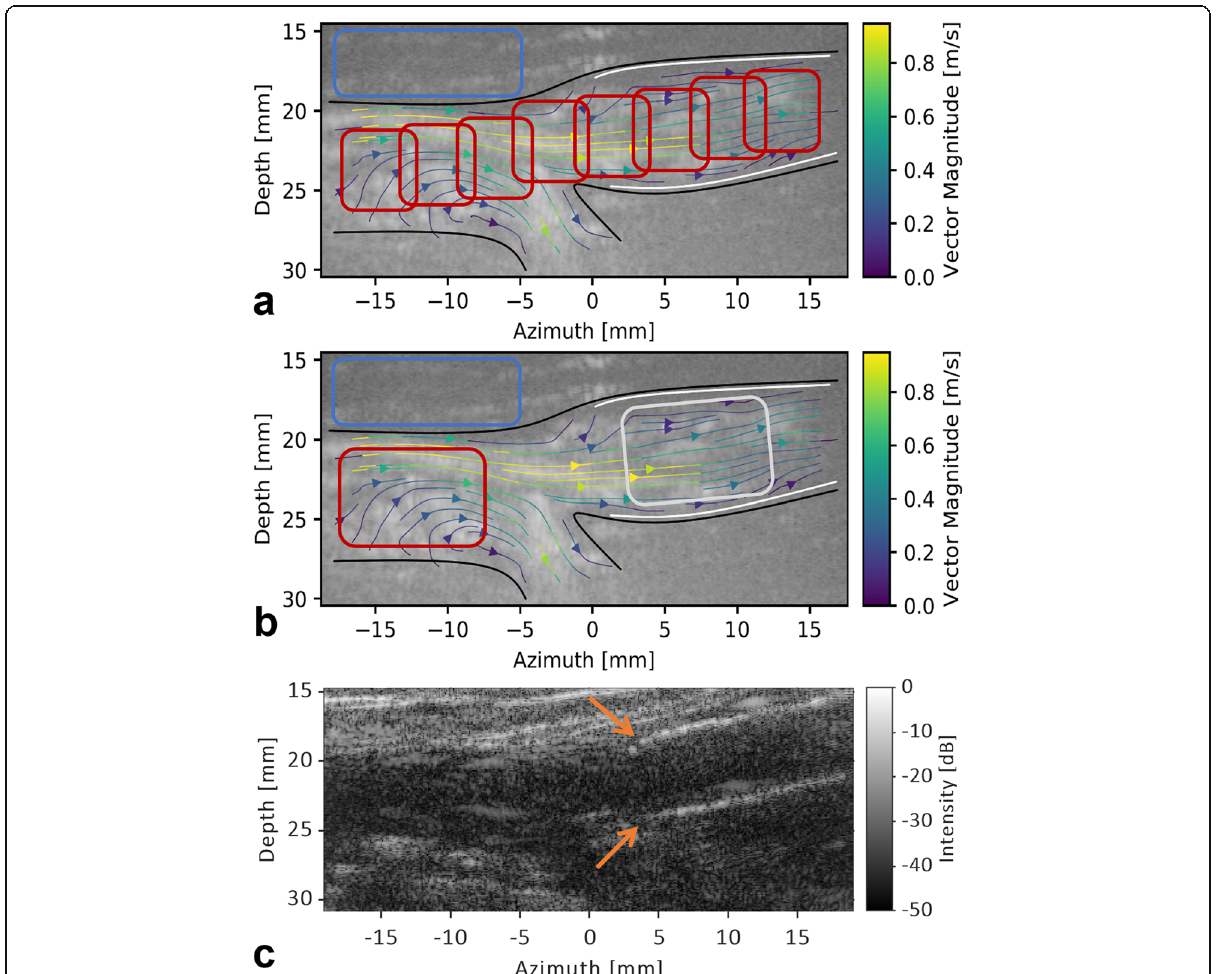
Fig. 3 Example indicating the stent location and regions of interest (ROIs) used for the quantitative analysis. a , b Filtered contrast-enhanced US image captured at the proximal edge of the stent (white lines) with the velocity streamlines superimposed. a ROIs used to analyse the entire imaged vessel. To calculate the contrast-to-tissue ratio (CTR), the red squares were used for contrast signal strength whereas the blue square was used for tissue signal strength. Black lines represent the delineation of the imaged vessel. All vectors inside this (masked) region were used to calculate the average vector correlation. b ROIs used to analyse the stent influence. CTR was calculated for both the red (contrast strength in native vessel segment) and grey square (contrast strength in stented vessel segment) compared to the blue square. The average vector correlation was computed over all vectors inside the red and grey square for the native and stented segment, respectively. c B-mode image used to identify the stent transition. Orange arrows indicate the proximal edge of the